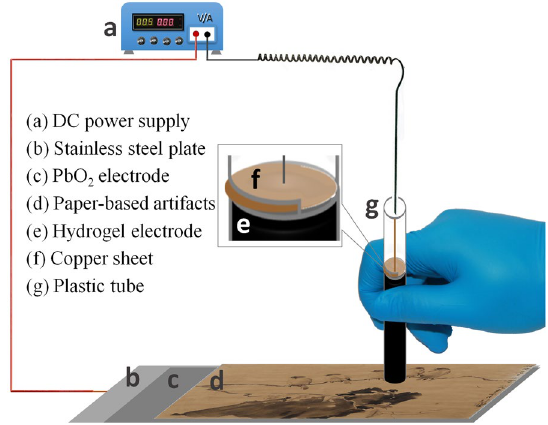
Figure 1. Schematic illustration of the HPEC